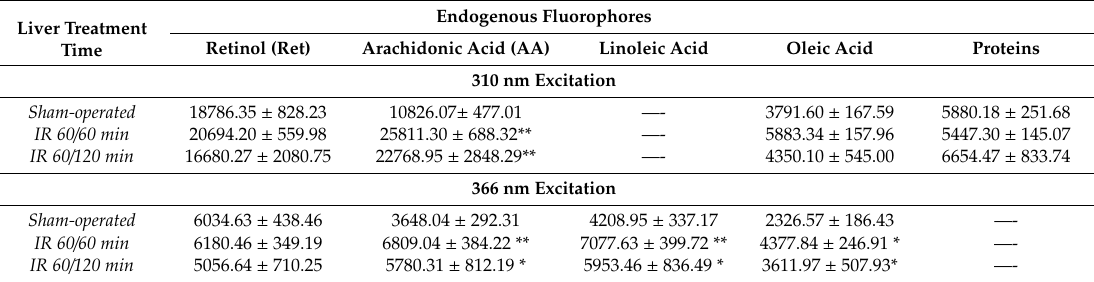
Table 3. Real contribution of the di ff erent endogenous fluorophores to the serum overall AF spectral area (390–600 nm range). (Means ±